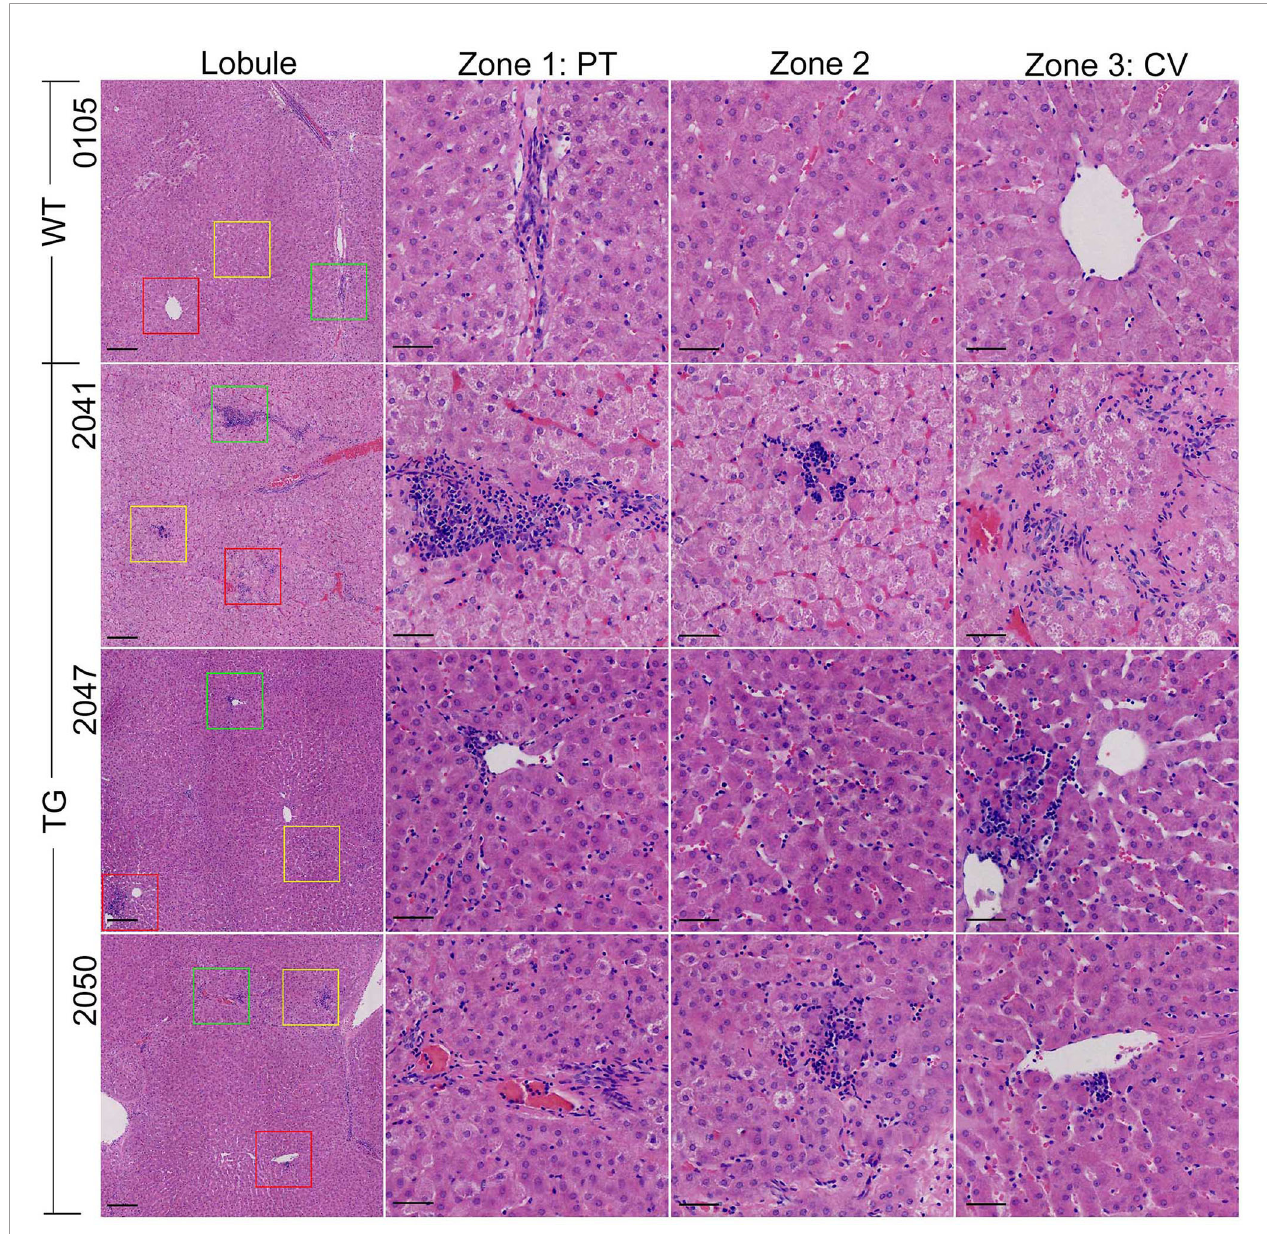
FIGURE 4 | HE staining of the liver. The vision selected from lobule view were marked with different colored boxes: green, zone 1; yellow, zone 2; red, zone 3; PT, portal area; CV, central vein. Scale bars are 100 m m in the lobule views and 50 m m in zones 1 – 3